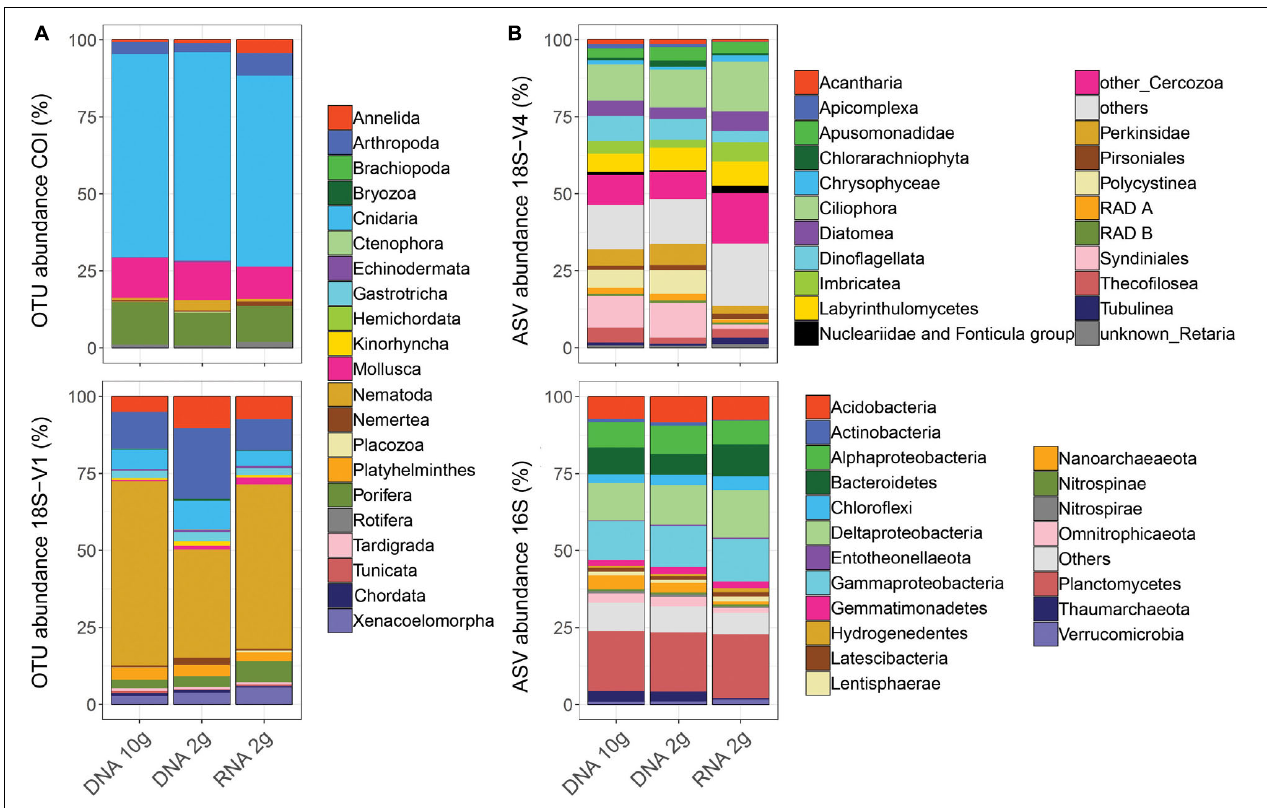
FIGURE 4 | Patterns of relative cluster abundance resolved by metabarcoding of sediment RNA and DNA from five deep-sea sites using either RNA/DNA extracted jointly from ∼ 2 g of sediment (RNA 2 g/DNA 2 g) or DNA extracted from ∼ 10 g of sediment (DNA 10 g) and using four barcode markers targeting metazoans ( A: COI, 18S-V1), micro-eukaryotes ( B: 18S-V4), and prokaryotes ( B: 16S). Values were calculated on balanced